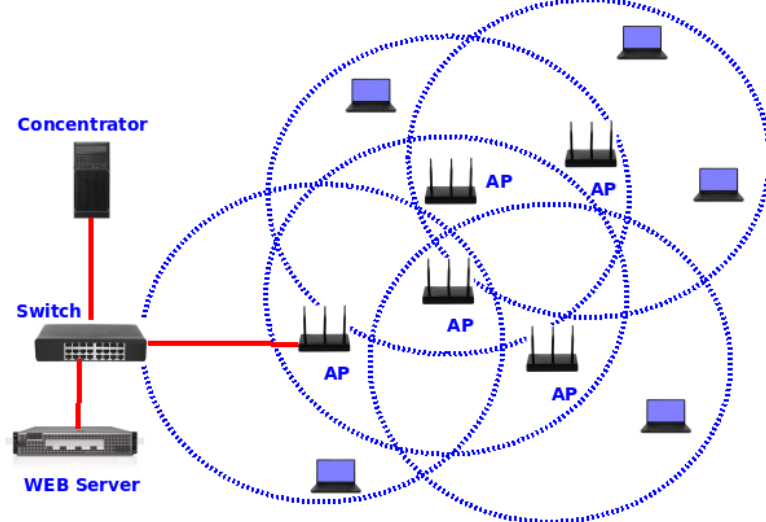
Figure 7. Experimental